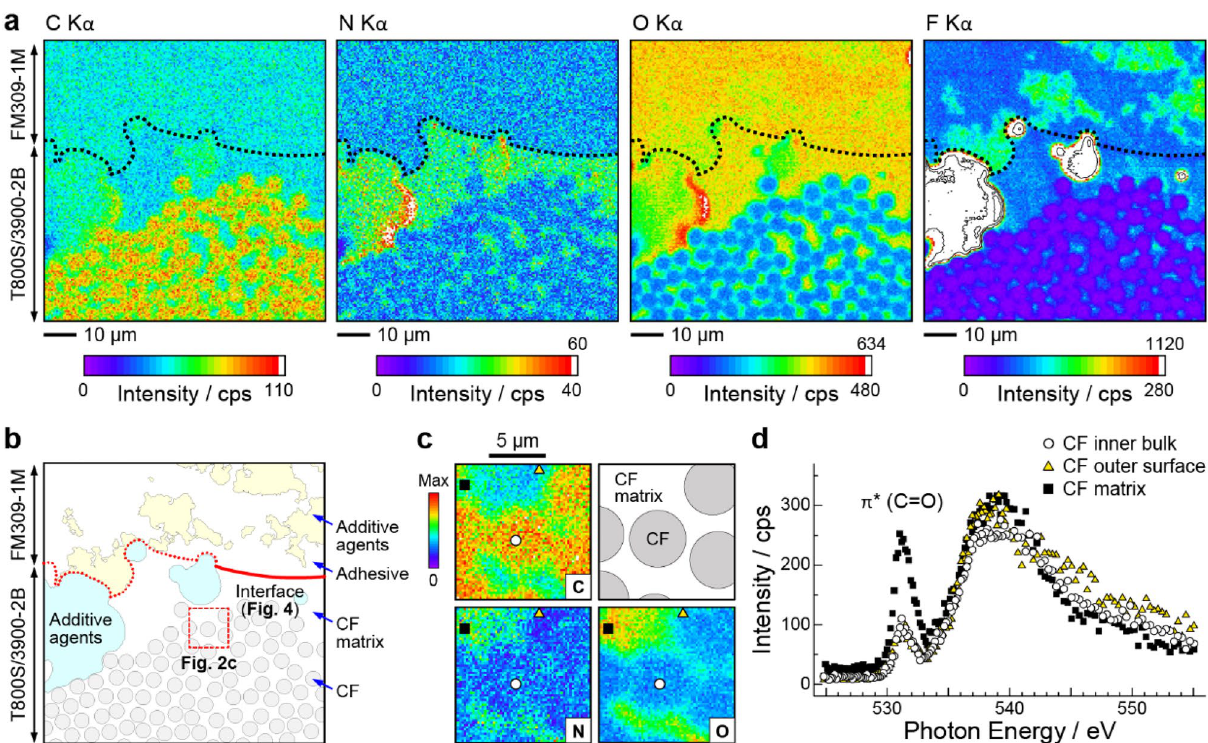
Figure 2. Soft X-ray images of the CF-matrix/adhesive interface. ( a ) The C, N, O, and F Kα SXM images of the CF-matrix/adhesive interface region measured at hv = 750 eV. The pixel size was 500 nm square and the dwell time was 1 s/pixel. The dashed curves in the images indicate the interface position, which was determined from the N Kα contrast. Contour lines with a step of 210 counts/s (cps) are shown in the whiteout areas of the F Kα image. ( b ) The segmented image of the CF-matrix/adhesive interface based on the SXM observations. The μ - XAS measurement was performed at the dashed square region ( c ). The intensity profile analysis cut across the interface was performed at the thick solid curve region (see Fig. 4a). ( c ) The C, N, and O Kα SXM images with a pixel size of 200 nm square. The circle, triangle, and square symbols in the image indicate the measurement spots of the μ -XAS spectra. ( d ) The O K-edge μ -XAS spectra measured at the CF inner bulk (circles), the CF outer surface (triangles), and the CF matrix